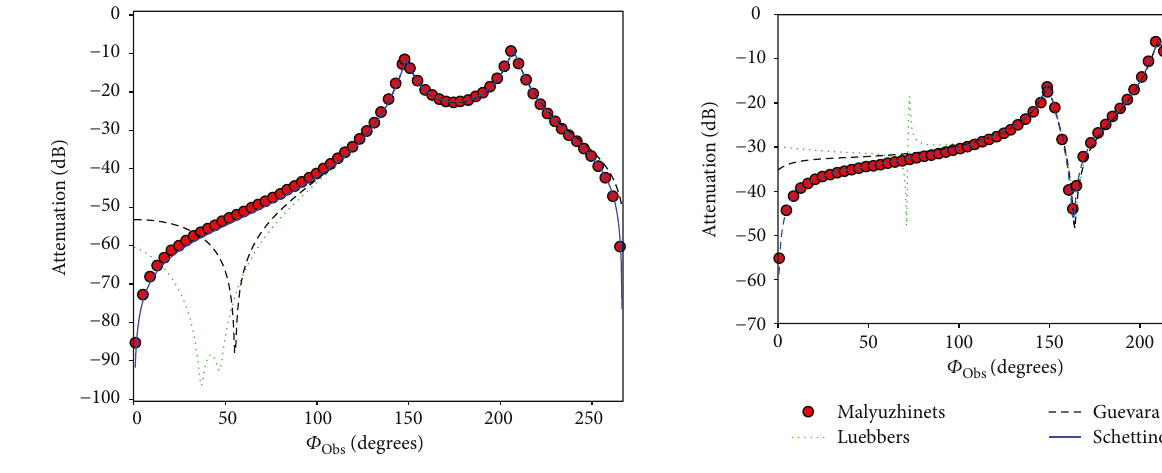
Figure 4: Attenuation of the di ff racted fi eld for TE polarization around the wedge; 0-face incidence and ϕ i = π /6 . Table 1: Statistics for the 0-face incidence.